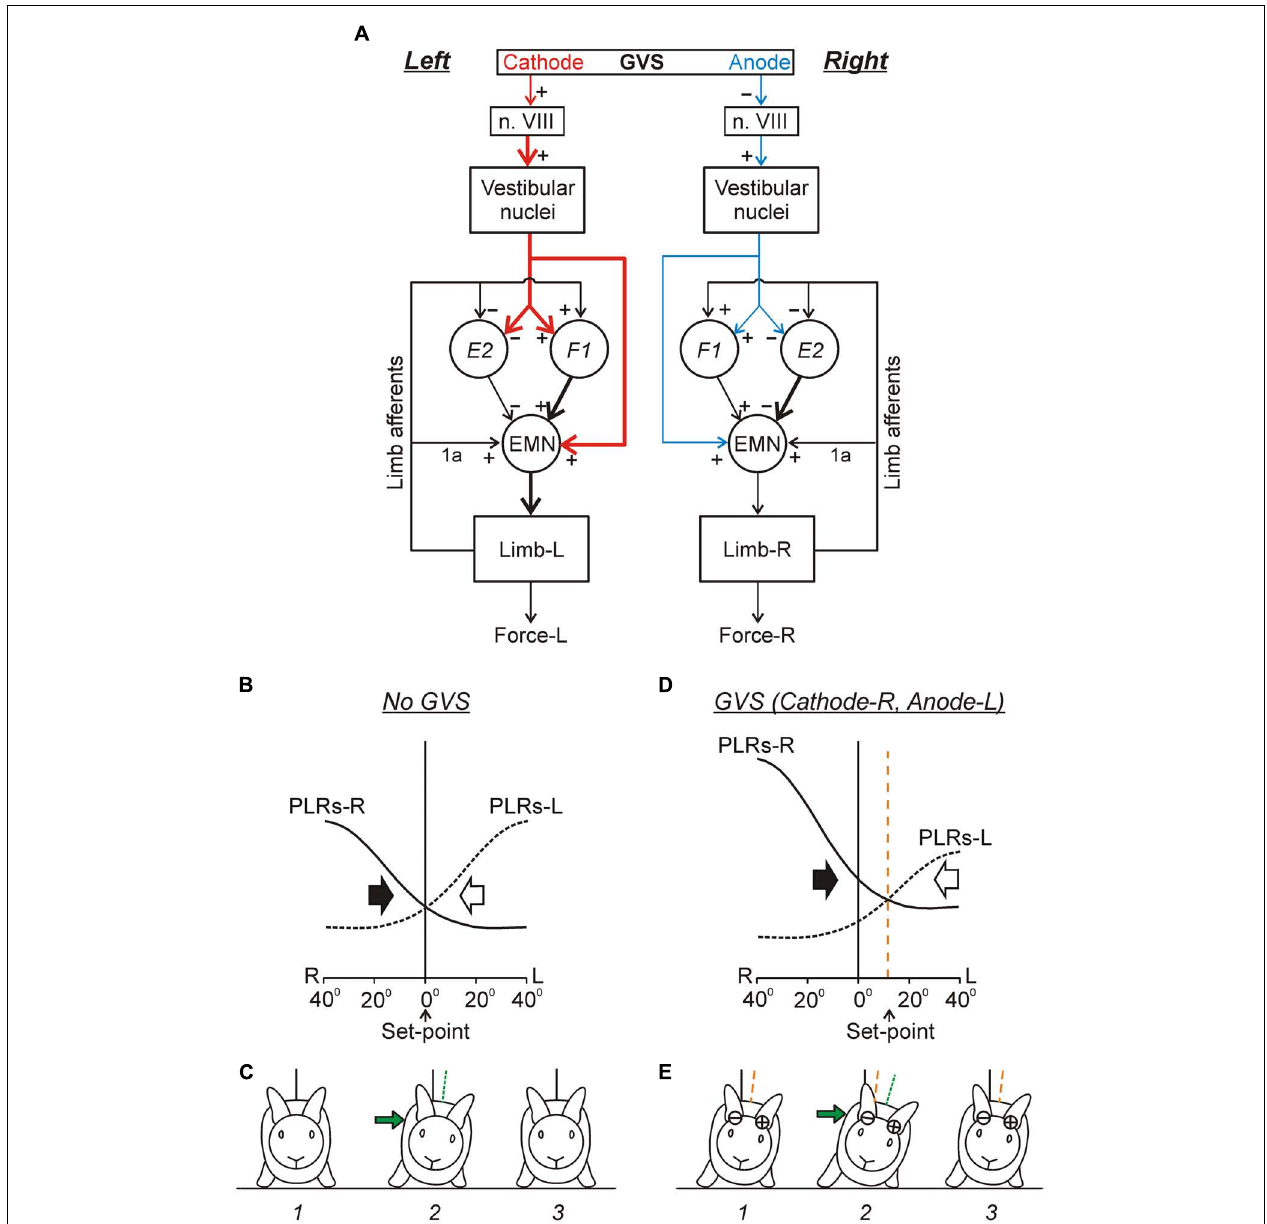
FIGURE 9 | Conceptual model of the trunk stabilization system and effects of galvanic vestibular stimulation. (A) Schematic representation of two chains of PLRs (Left and Right), as well as the effects of GVS on these chains. In each chain, flexion/loading of the limb activates afferents of this limb. They excite extensor motoneurons (EMNs) through monosynaptic pathways (group 1a afferents) and through polysynaptic pathways mediated by spinal interneurons (groups F1 and E2). Extensor motoneurons activate extensor muscles, which counteract the limb flexion. The GVS causes asymmetry of the two chains (indicated by different size and thickness of the corresponding red and blue arrows). With cathode on the left side, GVS activates vestibular afferents in the left VIII nerve (n. VIII), which activate neurons of the left vestibular nuclei. These neurons, through the left vestibulospinal tract, affect the spinal postural reflexes on the left side (for simplicity, crossed-effects are not